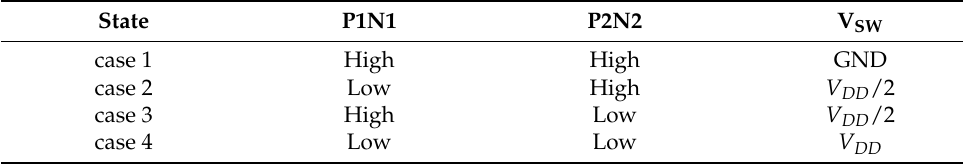
Figure 9. The four situations of V SW correspond to case 1–4, respectively. Table 1. States of the power transistors.